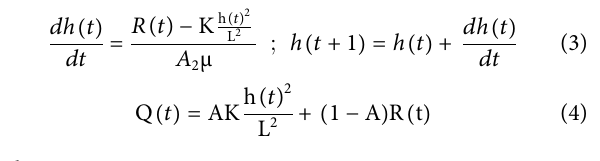
A 2 : second water table shape factor (Lesaffre, 1989), A 2 ≈ 0 . 89 (-); (cid:129) A: third water table shape factor (Lesaffre, 1989), A (cid:2) 0 . 869